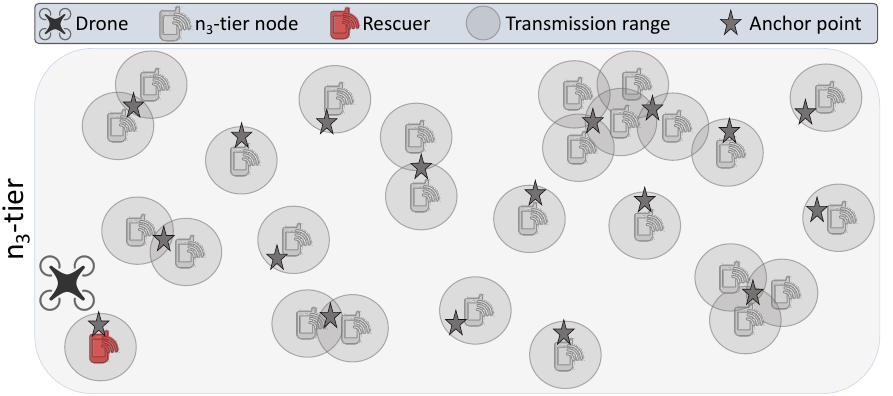
Figure 6. Drone anchor points shown with stars.